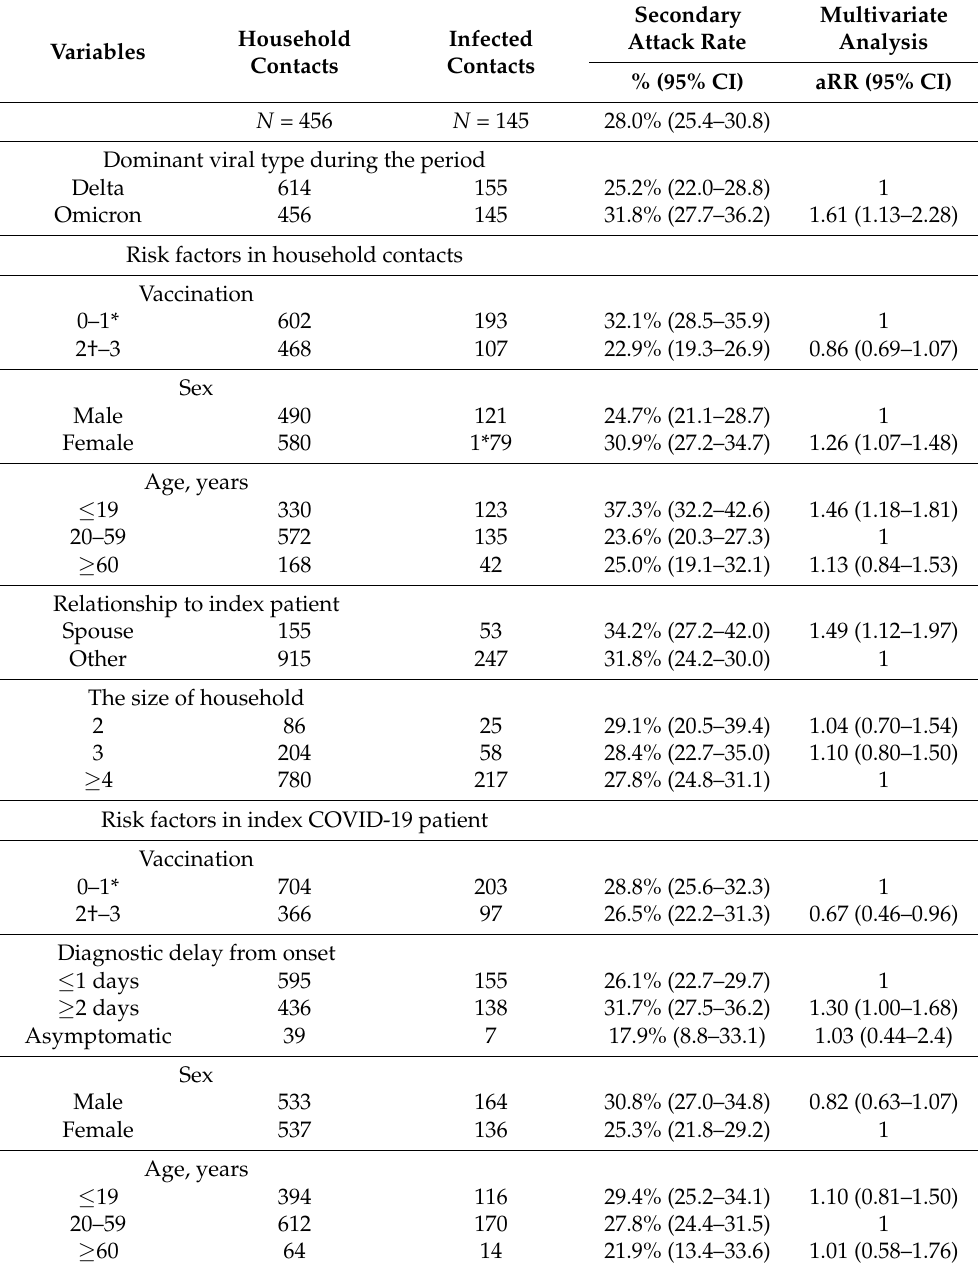
Table 2. Secondary attack rates among household contacts of index patients with COVID-19 by potential risk